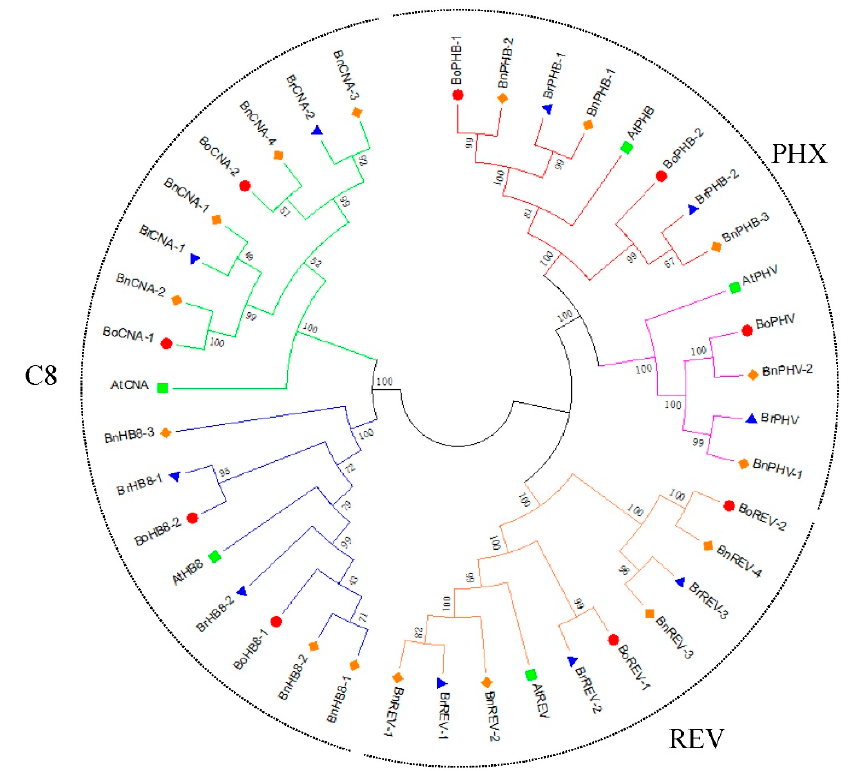
Figure 2. Phylogenetic relationships of HD-ZIP III genes from B. rapa , B. oleracea , B. napus and A. thaliana . The phylogenetic tree was constructed with MEGA7.0 software using the NJ method with 1000 bootstrap replicates. The blue triangles, red circles, orange diamonds and green squares represent the HD-ZIP III proteins in B. rapa , B. oleracea , B. napus and A. thaliana , respectively.